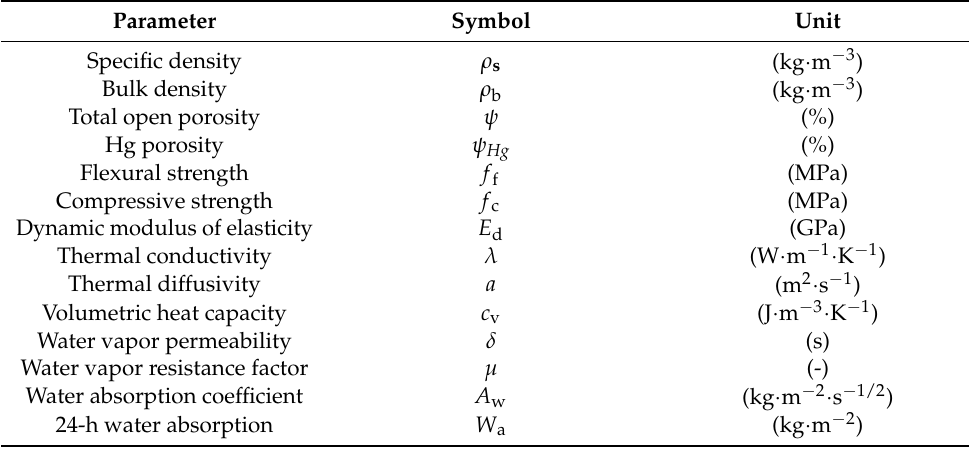
Table 2 summarizes a nomenclature of symbols used. Table 2. The nomenclature of used